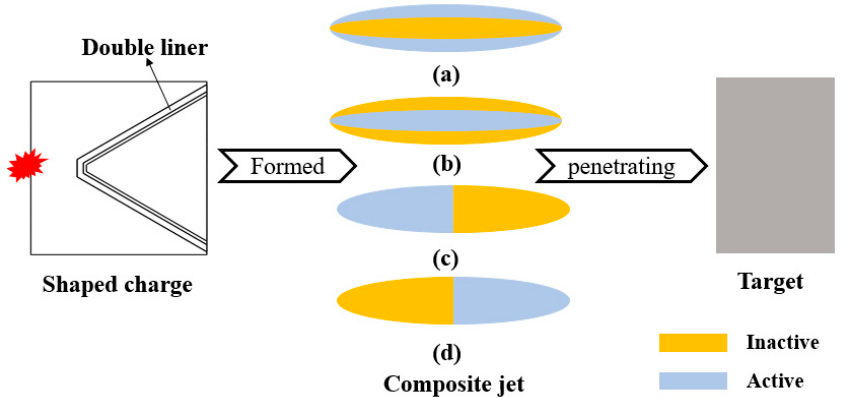
Figure 1. Elemental distribution within composite jets: ( a ) outer Al and inner Cu; ( b ) outer Cu and inner Al; ( c ) front Cu and rear Al; ( d ) front Al and rear Cu.